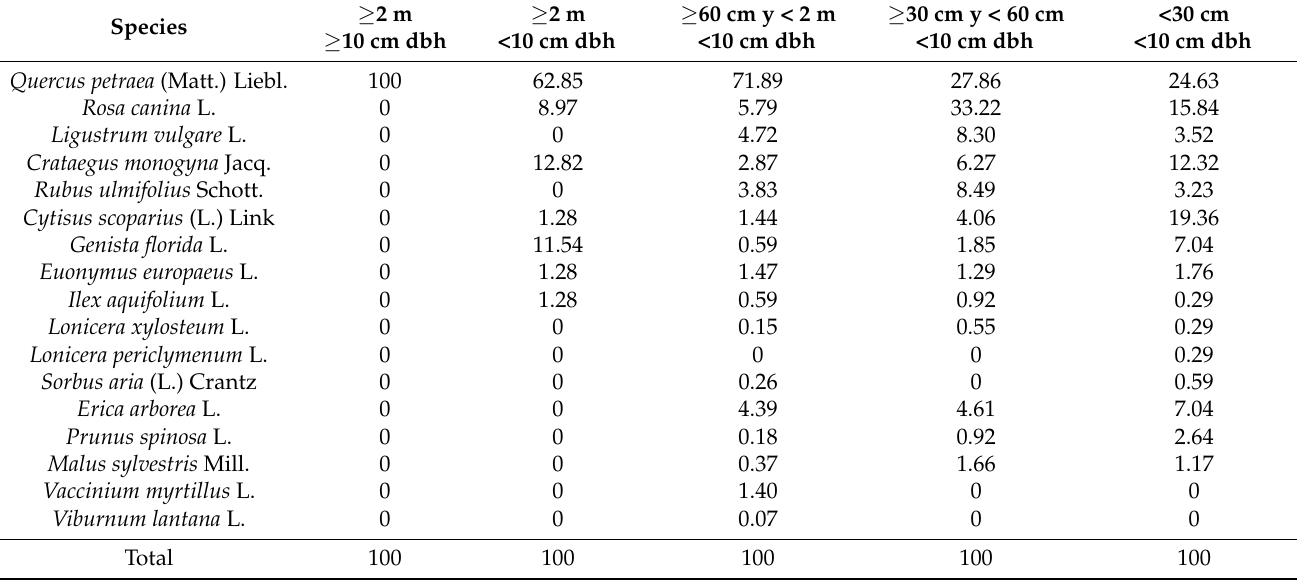
Figure A2. Details of vegetation sampling using transects (T). Table A1. Percentage of individuals (stems) of woody species in the forest edge (the nearest 11 m of the forest close to the mine sites) according to their size class; dbh = diameter at breast height (1.3 m); the five last species did not colonize the